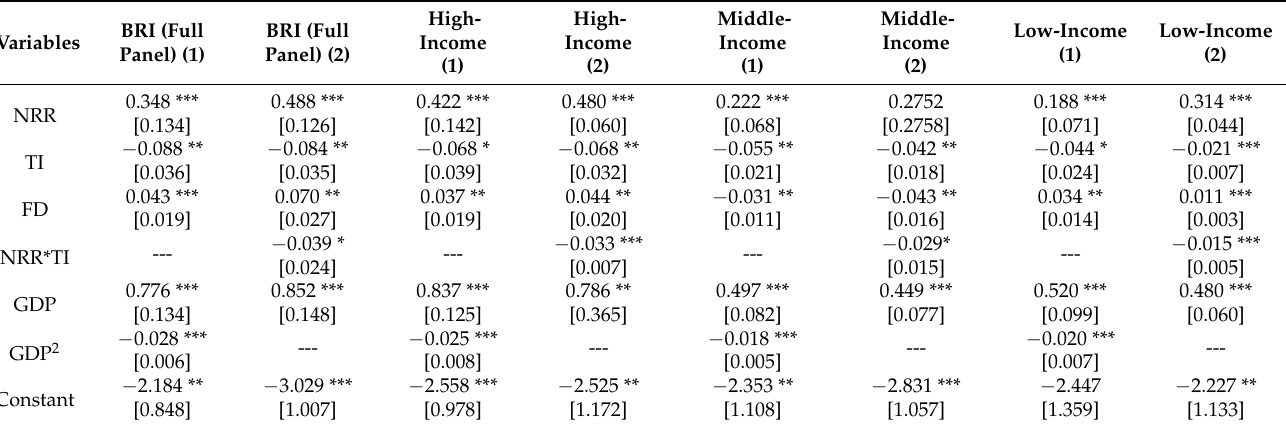
Table 5. Results of augmented mean group test